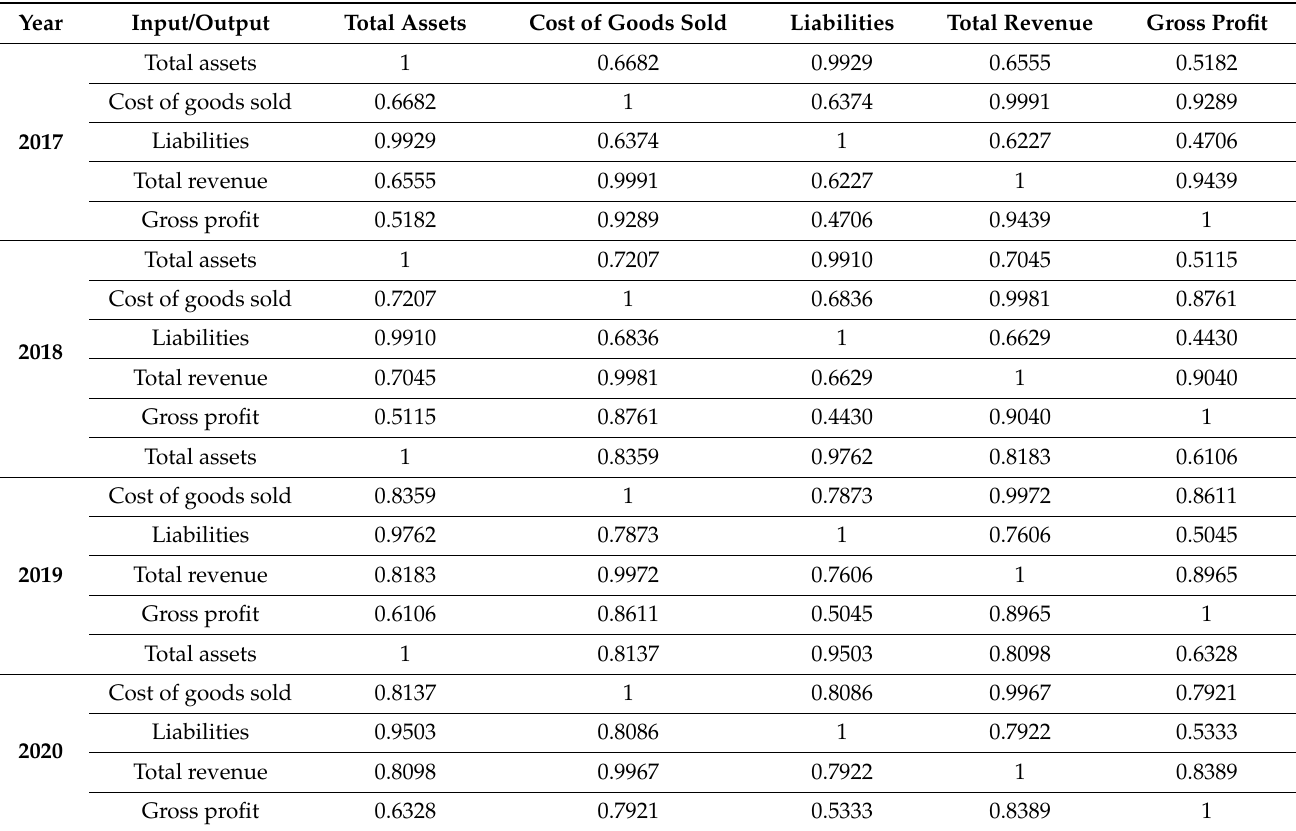
Table 11. Pearson’s correlation